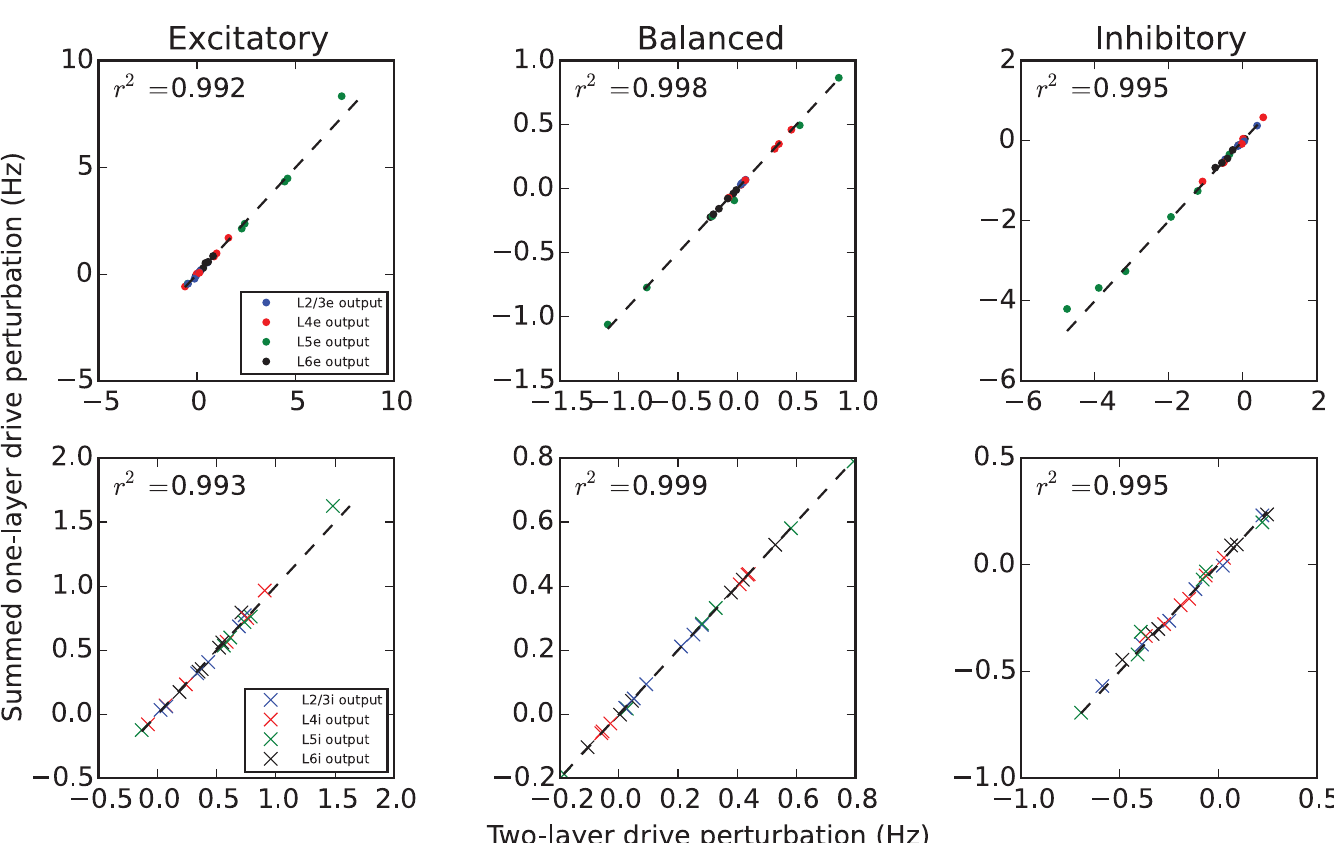
Fig 6. Additivity of output perturbations. All possible pairs of two input layers are selected to receive a 10 Hz step input in excess of background excitation. Dots and crosses indicate perturbations of excitatory (top) and inhibitory (bottom) populations computed by DiPDE, respectively (L2/3, blue; L4, black; L5, red; L6, green). For each possible pair of these input layers, the output of all populations is plotted versus the linear superposition of the same inputs taken independently, in two separate simulations (see main text for more details). Linear additivity of inputs between input layers results in points along the dashed identity line; this is the case for excitatory and balanced target specificity. As quantified by the coefficient of determination ( r 2 ) resulting from a linear fit, the balanced input regime results in a linear response, and deviates weakly from linearity when inputs are not balanced (See S2